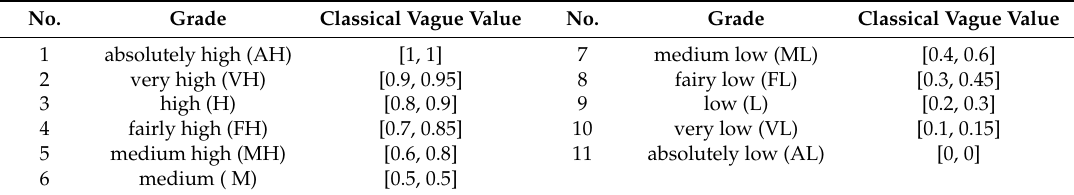
Table 1. The 11-grade linguistic variables in Vague